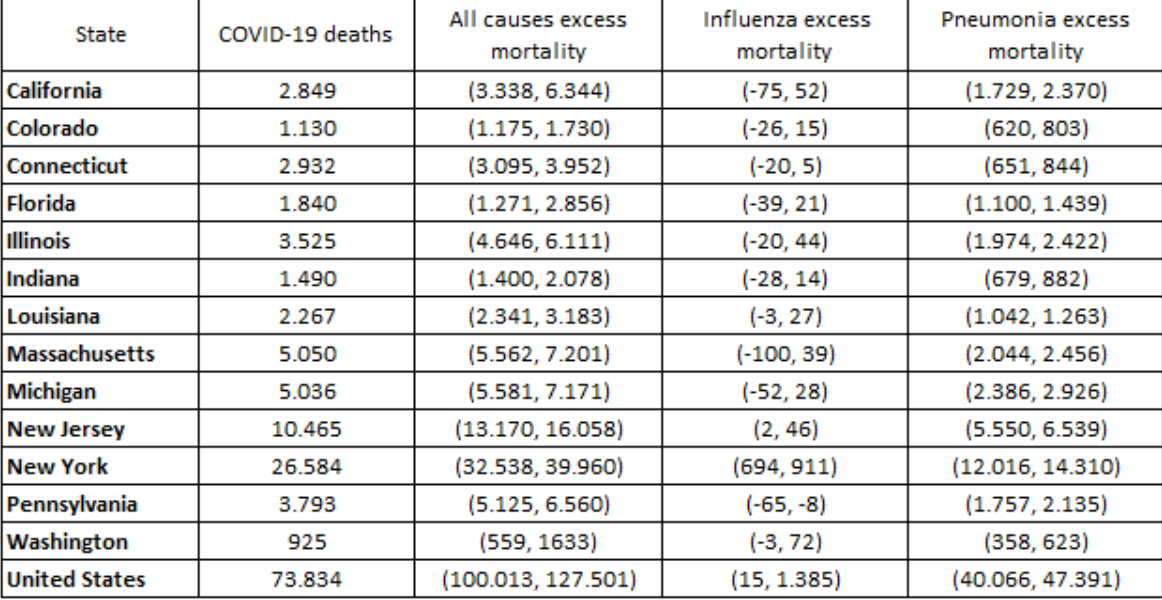
Table 1. Results for all causes, for influenza and for pneumonia of the 95% confidence intervals obtained from the semi parametric model compared with the COVID-19 deaths